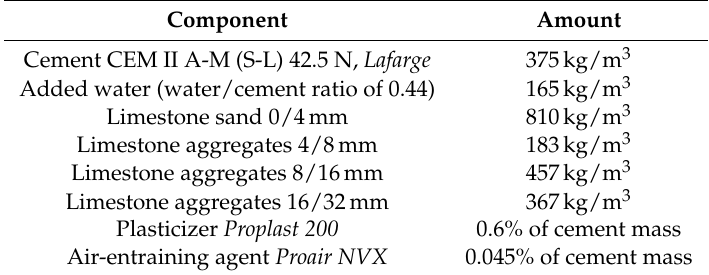
Table 1. Composition of the concrete mixture (concrete grade